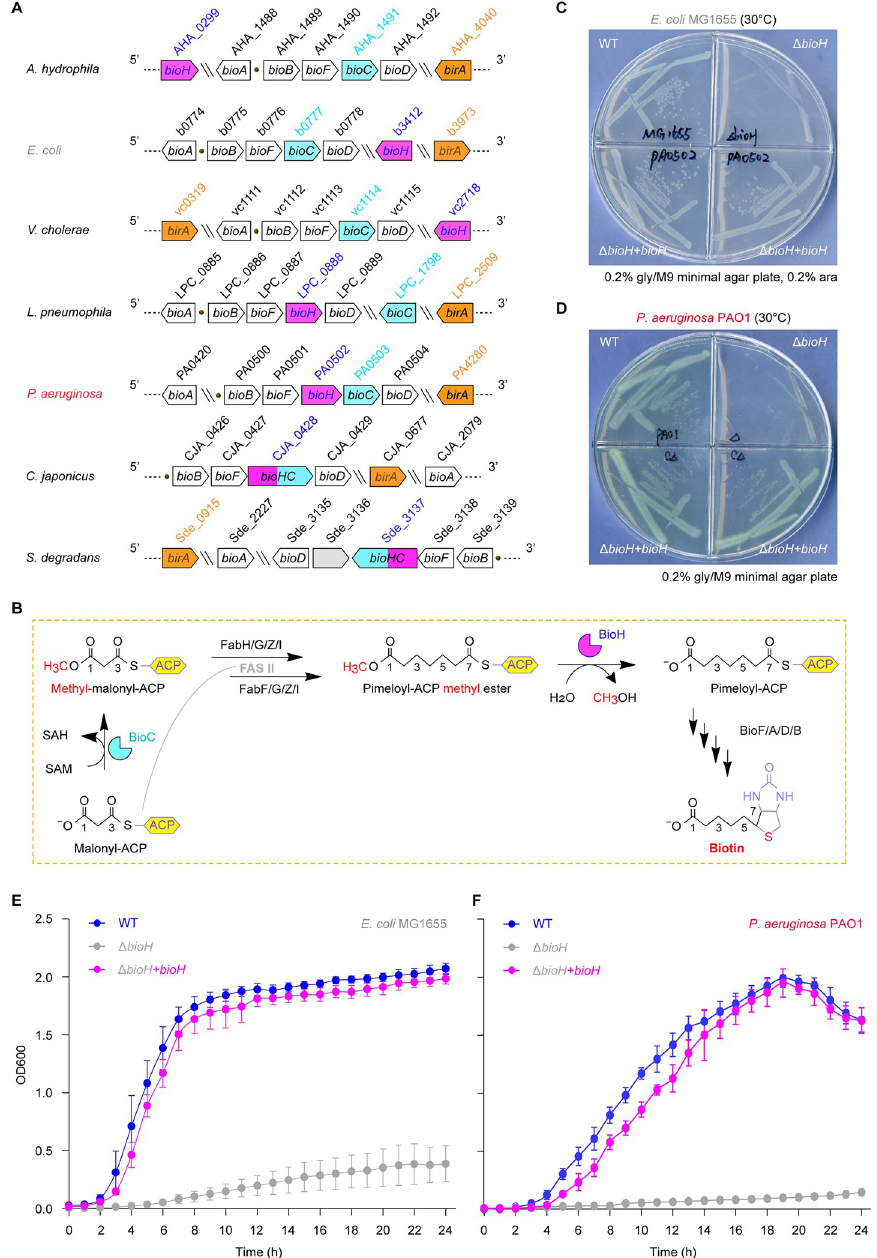
Fig 1. A role of PA0502 in biotin synthesis pathway A. Genetic context of Pseudomonas aeruginosa bioH (PA0502) and its counterparts in certain microorganisms B. A model for ‘BioC-BioH’ path of biotin synthesis in P . aeruginosa . C. Expression of PA0502 allows growth of the biotin auxotroph of E . coli Δ bioH on the non-permissive condition of M9 minimal medium. D. The removal of PA0502 renders P . aeruginosa biotin auxotrophic. A representative result from three independent experiments (in panels C & D ) is given. E. Growth curves of the E . coli Δ bioH strains with or without plasmid-borne bioH (PA0502). F. Growth analyses of P . aeruginosa Δ bioH mutant and its complemented strain. As for plotting growth curves, the data is expressed in means ± standard deviation (SD) of three independent experiments (in panels E & F ). Designations: SAM, S-adenosylmethionine; SAH, S-Adenosylhomocysteine; ACP, acyl carrier protein; FASII, Fatty acid synthesis type II; FabH, β -ketoacyl-ACP synthase III; FabF, β -ketoacyl-ACP synthase II; FabG, 3-keto-acyl-ACP reductase; FabZ, β -hydroxy-acyl-ACP dehydratase; FabI, enoyl-ACP reductase; BioC, O- methyltransferase of malonyl-ACP; BioH, demethylase of pimeloyl-ACP methyl ester; BioF, 8-amino-7-oxononanoate synthase; BioA, 7,8-diaminopelargonic acid synthase; BioD, dethiobiotin synthetase; BioB, biotin synthase.